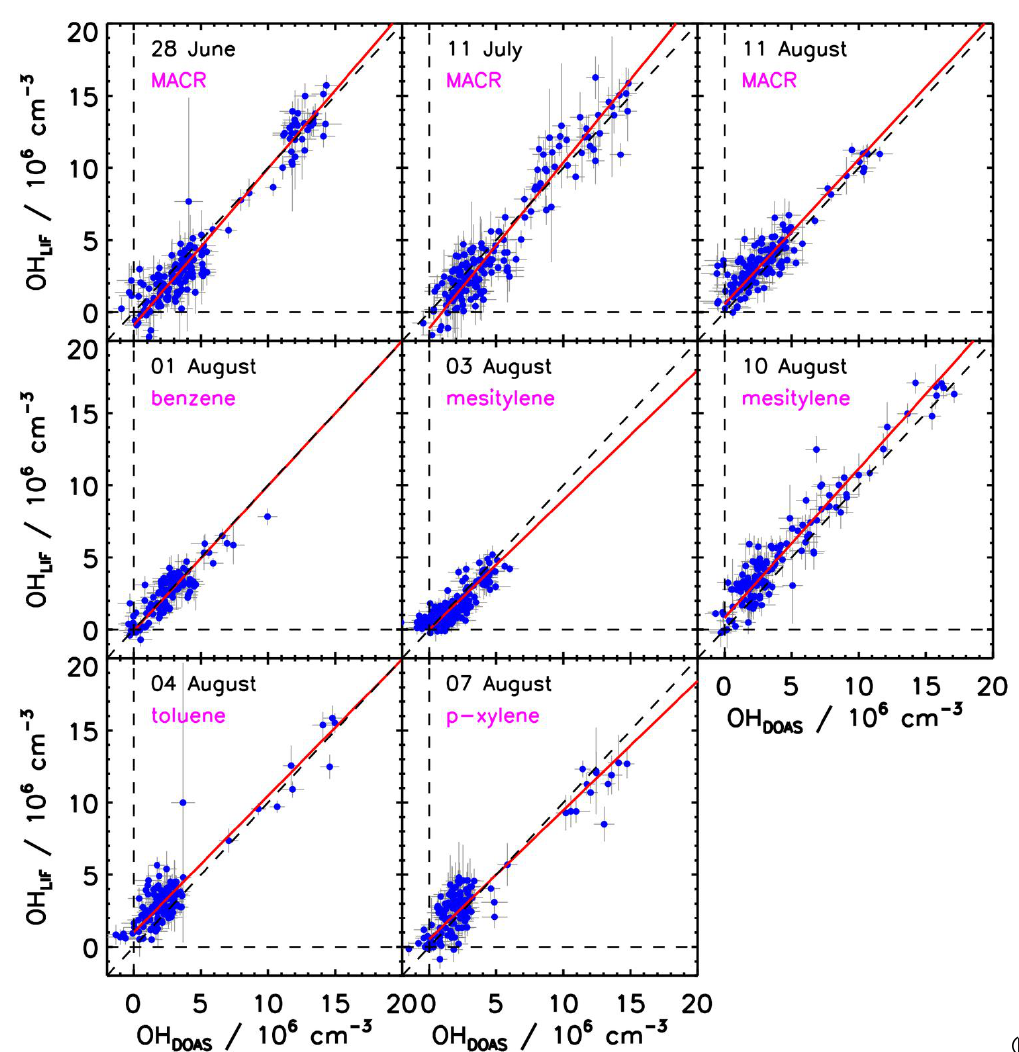
Fig. 5. Correlation of OH concentration measurements by DOAS and LIF for individual experiments. LIF data are averaged to the time resolution of DOAS measurements. Red lines give the result of the regression analysis shown in Table 3. No OH reactant was added during “zero air”